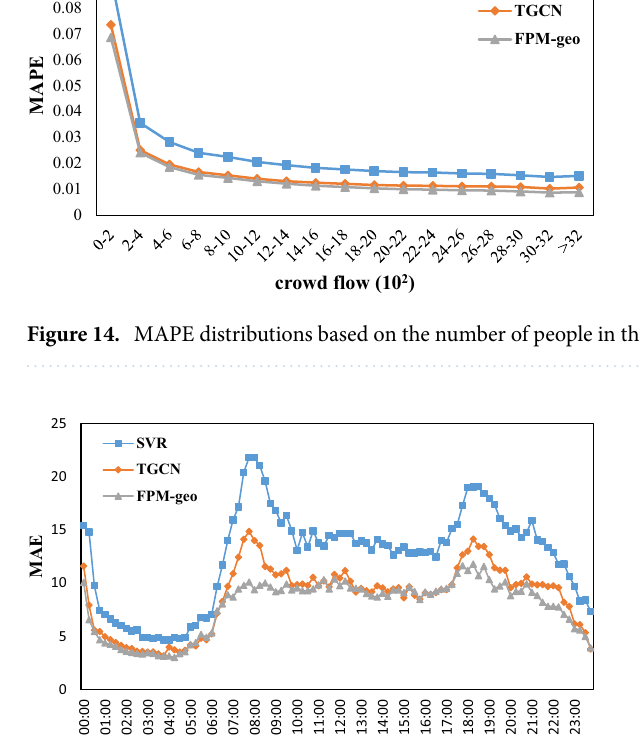
Figure 15. Time distribution of the MAE of each